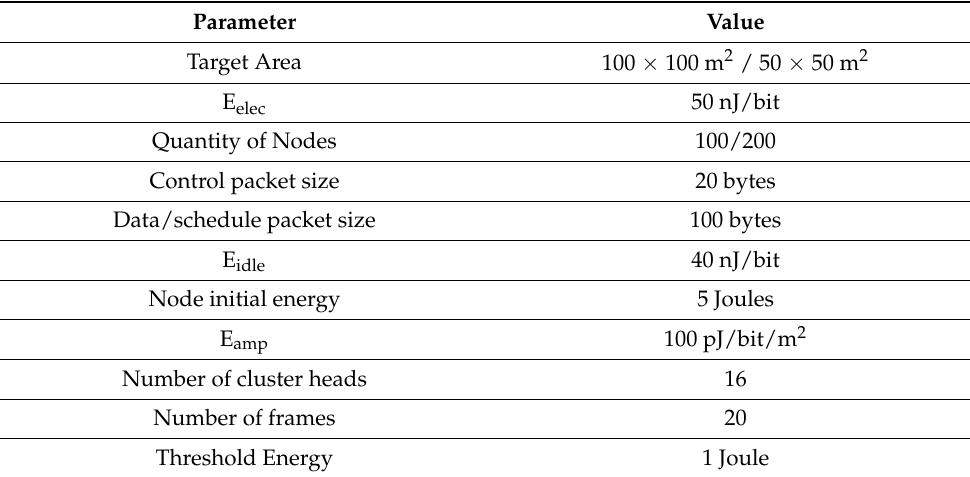
Table 2. : Simulation